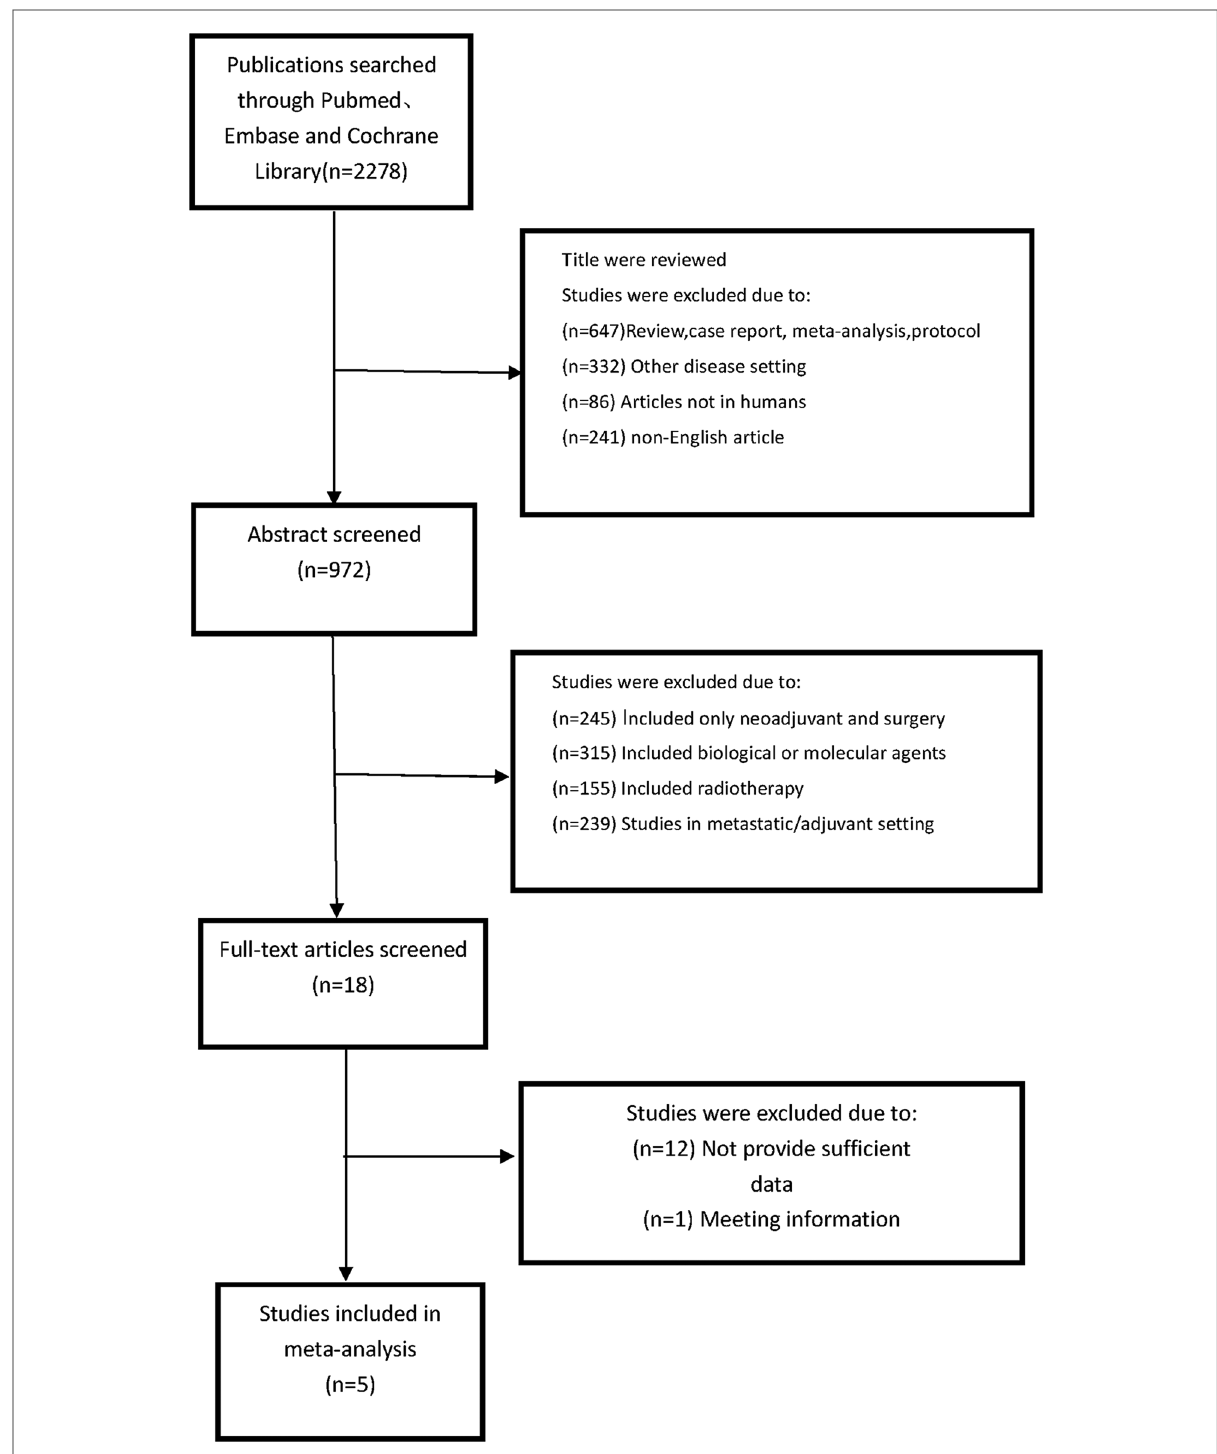
FIGURE 1 PRISMA 2009 fl ow diagram of the selection of included